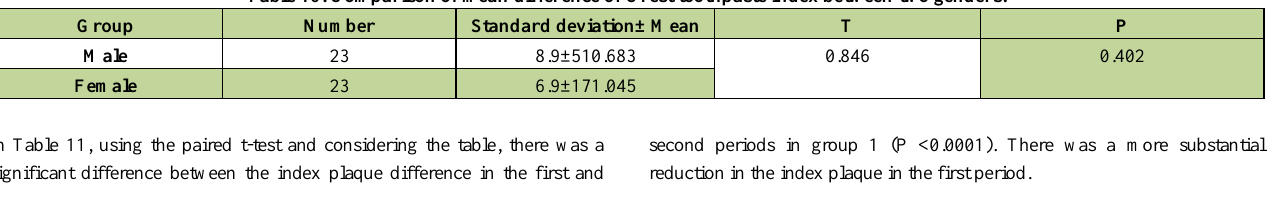
Table 11. Comparison of mean difference between index plaque in the first and second period in the group I.